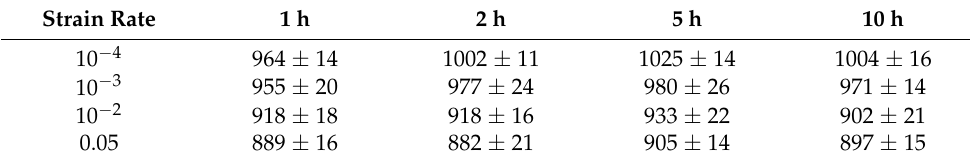
Table 4. The tensile strength of the tested steel under different strain rates